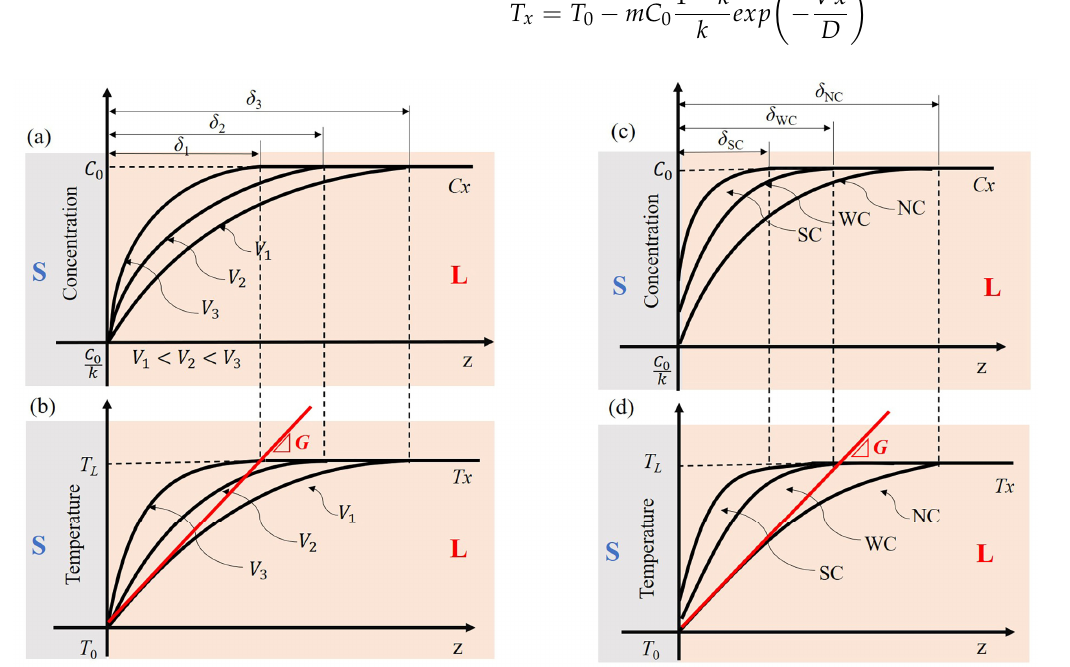
Figure 7. Schematic illustrations of the constitutional supercooling ahead of the S-L interface under various conditions. ( a ) Solute concentration curves under various growth rates; ( b ) Temperature curves under various growth rates; ( c ) Solute concentration curves under various intensities of melt convection; ( d ) Temperature curves under various intensities of melt convection. δ 1 , δ 2 and δ 3 denote different solute boundary layers under various growth rates, respectively. δ NC , δ WC and δ SC denote different solute boundary layers under various intensities of melt convection, respectively.